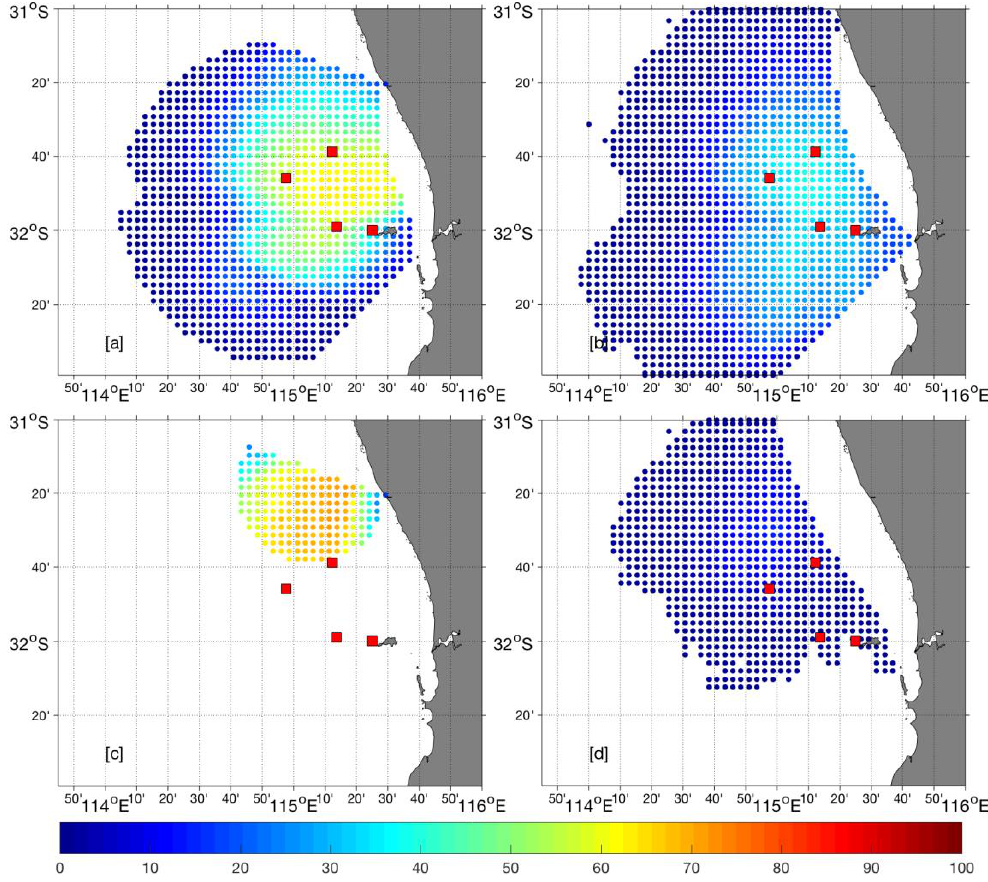
Figure 3. Data return maps for different HFR network configuration: ( a ) refers to FRE – GUI stations (default ROT WERA configuration); ( b ) shows the coverage obtained merging FRE and LANC radial data; ( c ) same as ( b ) but for the GUI – LANC pair; and ( d ) coverage obtained with the FRE – GHED configuration. The colormap documents the percent data availability for the different configurations. Locations of the moorings are marked as red squares. Refer to Figure 1 for the codes of the HFR systems and the moorings.